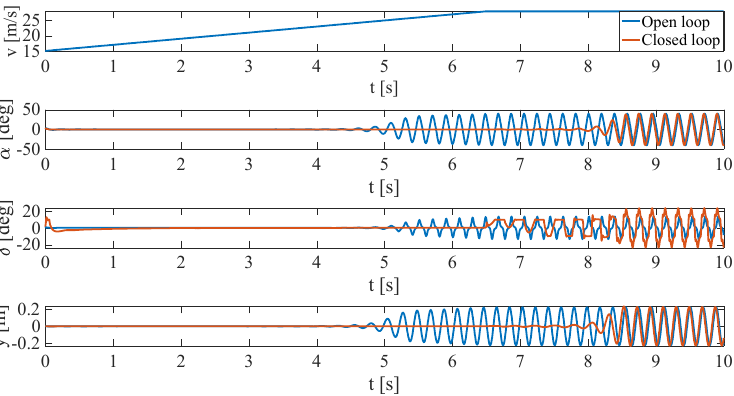
Figure 16. Comparison between open-loop and closed-loop responses to the linear velocity variation.